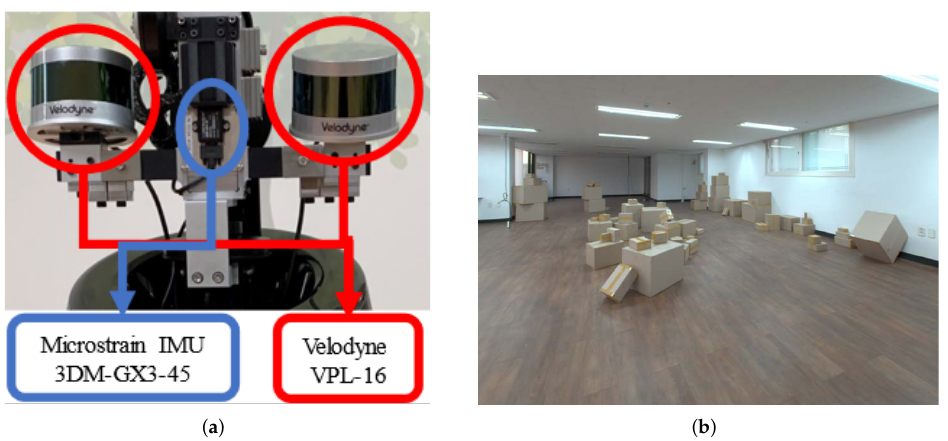
Figure 8. Real data acquisition setting. ( a ) Sensor system configuration. Sensor system used to acquire point clouds is consisting of two Velodyne VLP-16 channels and Microstrain 3DX-GX3-45 model. ( b ) Environment in which SLAM is executed to obtain real point cloud data of cuboid.